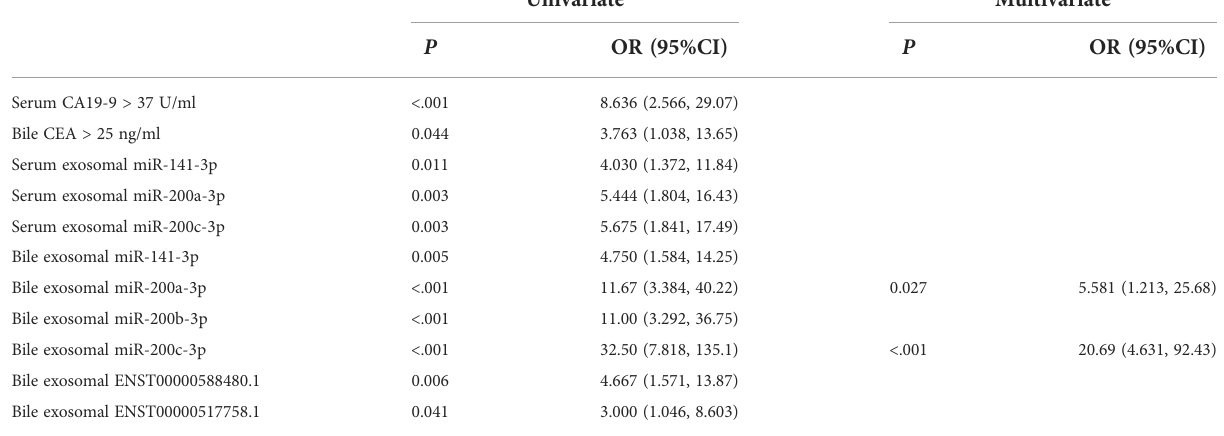
TABLE 4 Potential biomarkers of CCA.